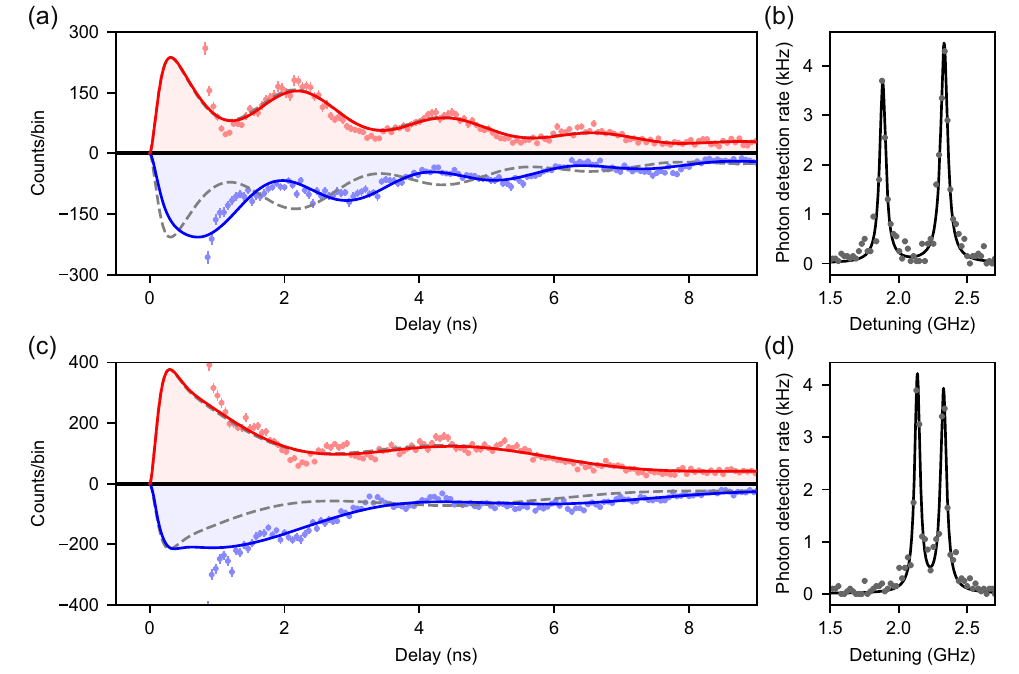
FIG. 5. Chiral single-photon scattering from a pair of emitters in a WGM resonator. (a) The emitter pair is excited through the CW mode. Photons scattered into the CW (red) and CCW (blue) mode are time correlated to the excitation pulse, tracing out the temporal shape of the emitted single-photon wave packet. Error bars represent standard error. The solid red and blue lines represent the simulated a a expectation values h a † and h a † , respectively. The asymmetric CW and CCW emission arises from nontrivial emitter CW i CCW i CW CCW phase difference, inferred to be ð 0 . 34 π mod π Þ . The simulated case where ϕ ¼ 0 is shown as a gray dotted curve, in which case the emission is symmetric. (b) The PLE spectrum of the two emitters shows frequency separation of 0.44 GHz, which is used as a fixed parameter in the simulation of the wave packet in (a). (c),(d) Same as (a),(b) but for emitter frequency separation of 0.19 GHz, with inferred phase ϕ ¼ ð 0 . 28 π mod π Þ